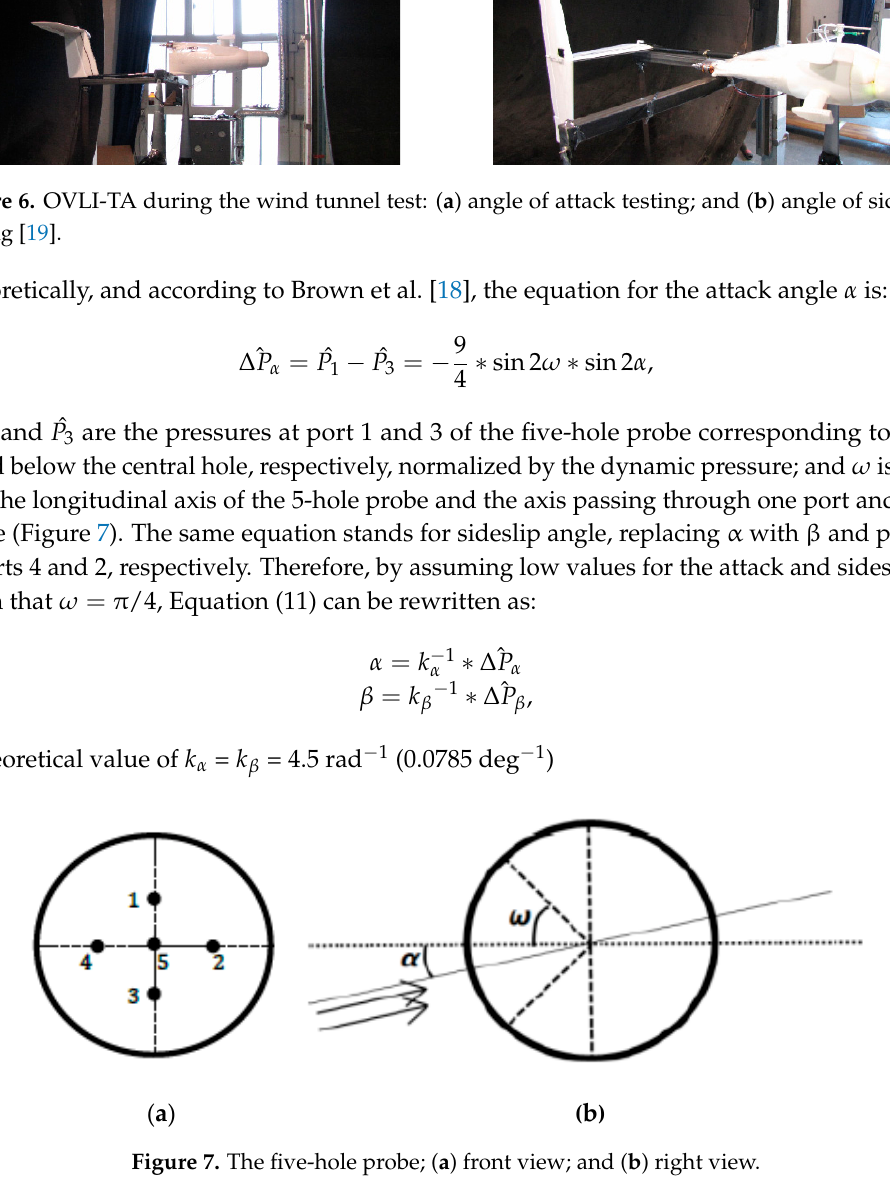
Figure 6. OVLI-TA during the wind tunnel test: ( a ) angle of attack testing; and ( b ) angle of sideslip testing [19].